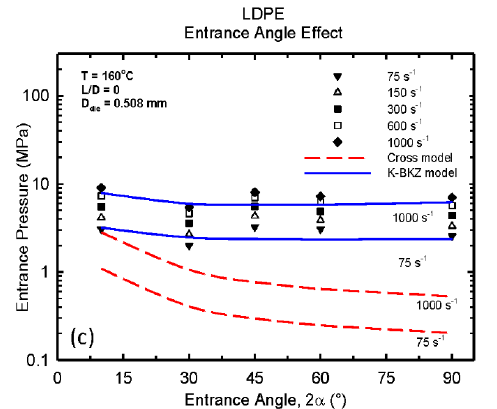
Figure 2. The entrance pressure of ( a ) LLDPE ( b ) HDPE and ( c ) LDPE at 160 ◦ C as a function of contraction angle at various values of apparent shear rate.